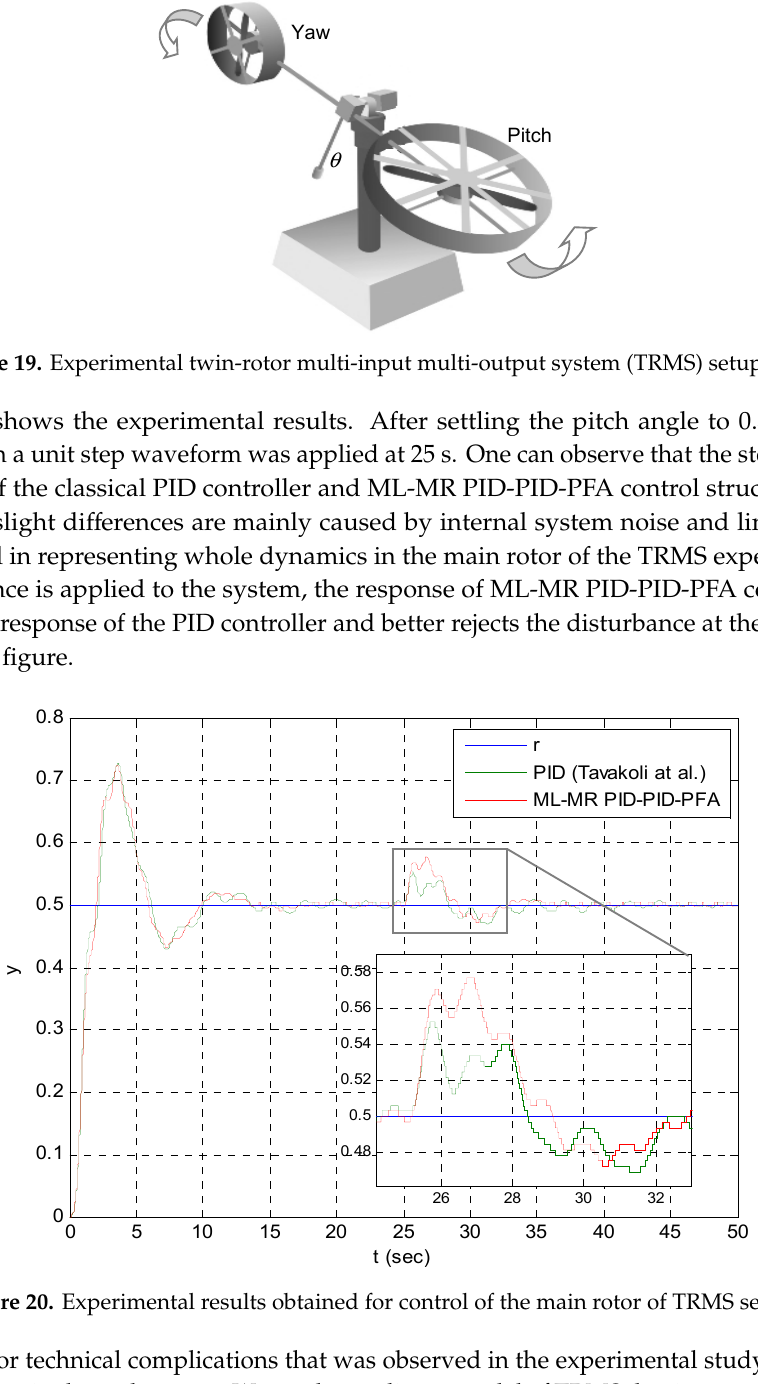
Figure 20. Experimental results obtained for control of the main rotor of TRMS setup.